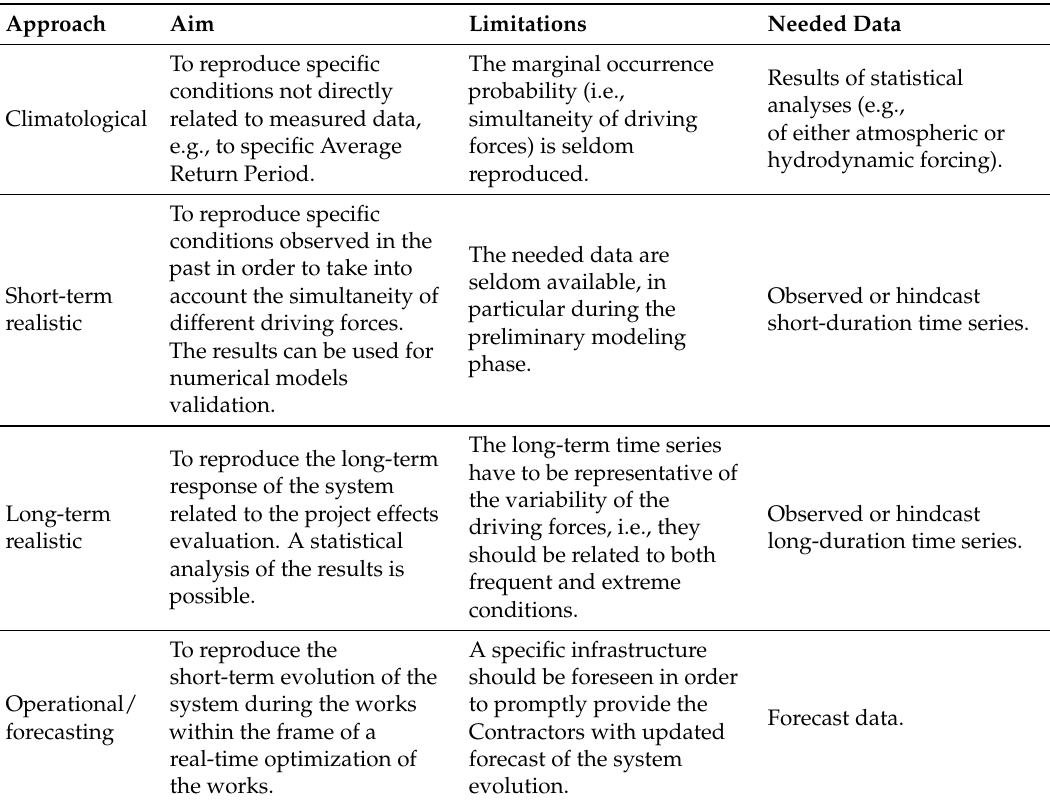
Table 1. Main features of the modeling scenarios proposed within the different accuracy levels of the proposed integrated